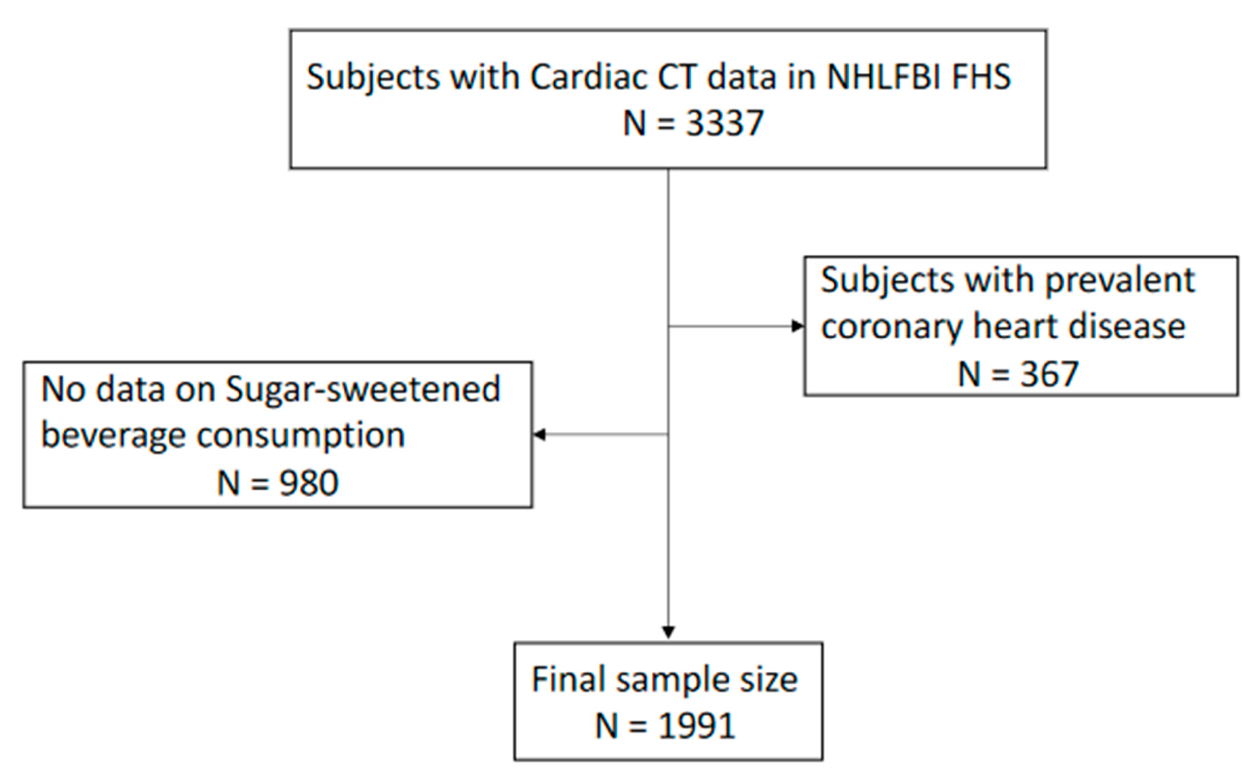
Figure 1. Study population. CT, Computed Tomography; NHLBI FHS, The National Heart, Lung, and Blood Institute Family Heart Study